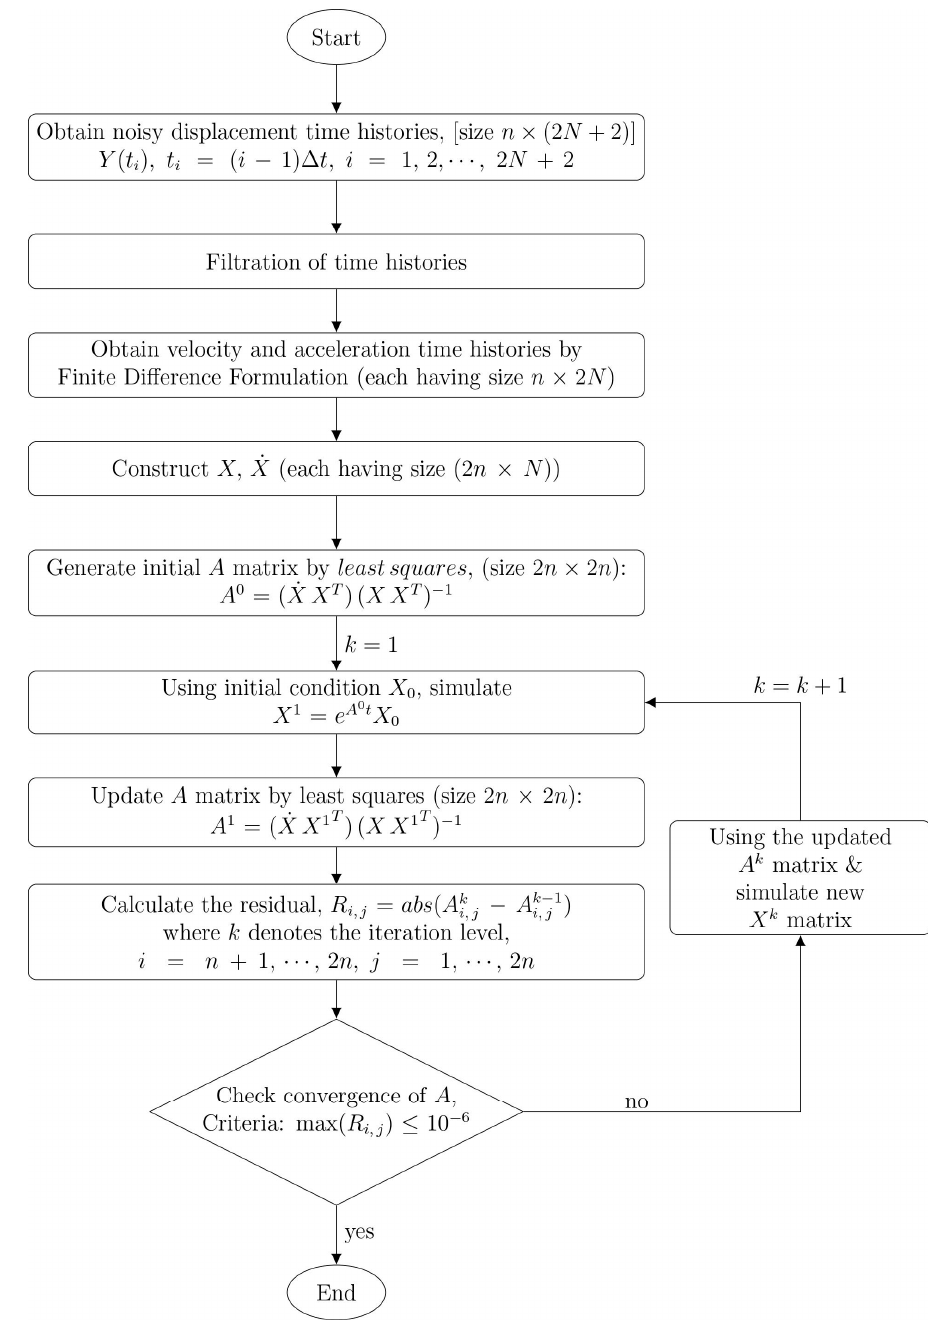
Figure 3. Flowchart of the iterative squares approach (ILS) algorithm [33].